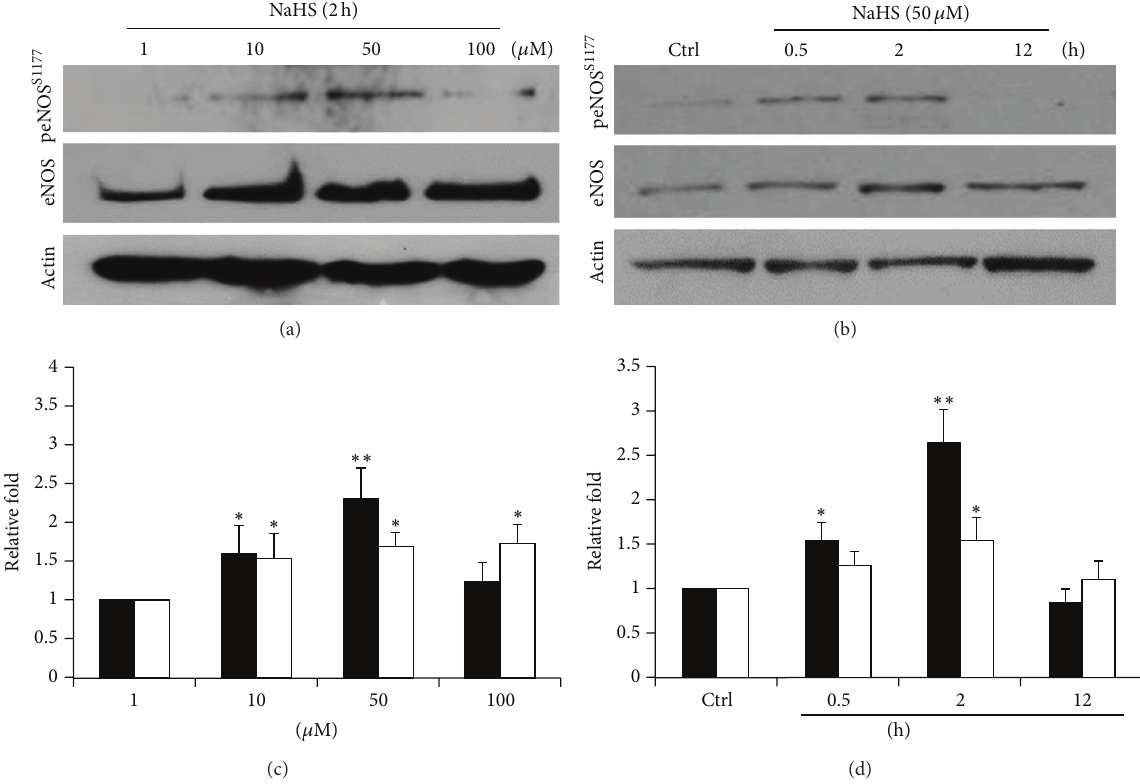
Figure 1: NaHS increases the expression and serine 1177 phosphorylation of eNOS. (a) ECs pretreated by diluting concentrations of NaHS (1 𝜇 M, 10 𝜇 M, 50 𝜇 M, and 100 𝜇 M) for 2 h. (b) ECs treated with NaHS (50 𝜇 M) for 0.5, 2, and 12h. Blotted membranes were separately hybridized with eNOS and peNOSS1177 antibodies. ((c) and (d)) Relative folds of protein levels shown as means ± S.E. compared to control. Statistical significance ( ∗ 𝑃 < 0.05 ; ∗∗ 𝑃 < 0.01 ) analyzed using Fisher’s